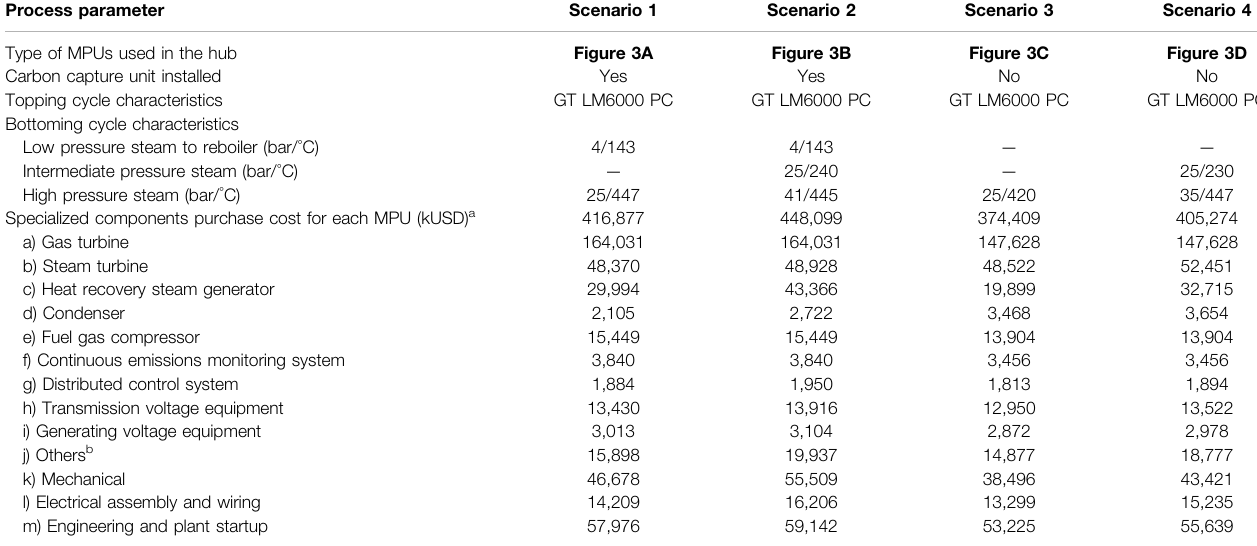
TABLE 2 | Optimal design operating parameters and other economic characteristics of the MPUs with and without CCS unit corresponding to each studied scenario. Process parameter